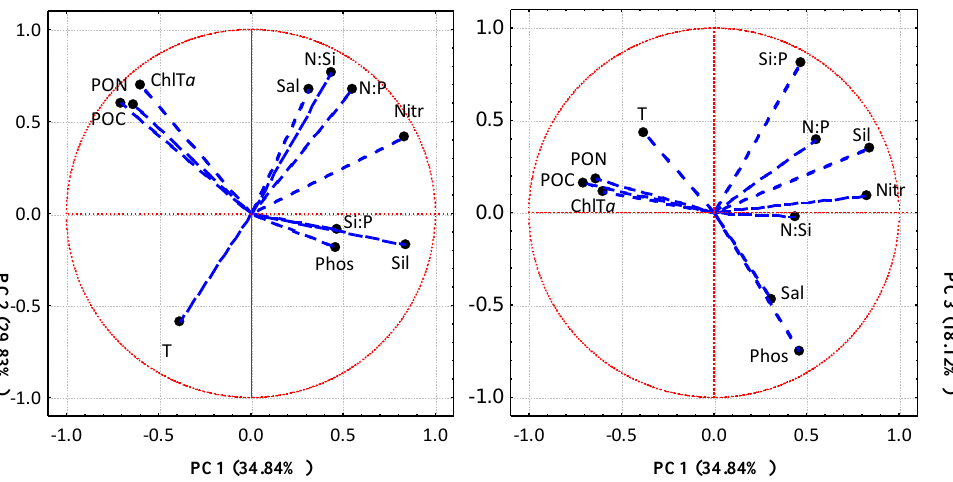
Figure 7. Vector-plots of the variable factor coordinates extracted from the principal component analysis (PCA); data coming from all samples collected in the euphotic layer were used. T, temperature; Sal, salinity; Nitr, nitrate; Phos, phosphate; Sil, silicate; N:P, molar ratio of nitrate+nitrite to phosphate; N:Si, molar ratio of nitrate+nitrite to silicate; Si:P, molar ratio of silicate to phosphate; ChlT a , total chlorophyll a ; POC and PON, particulate organic carbon and nitrogen, respectively.